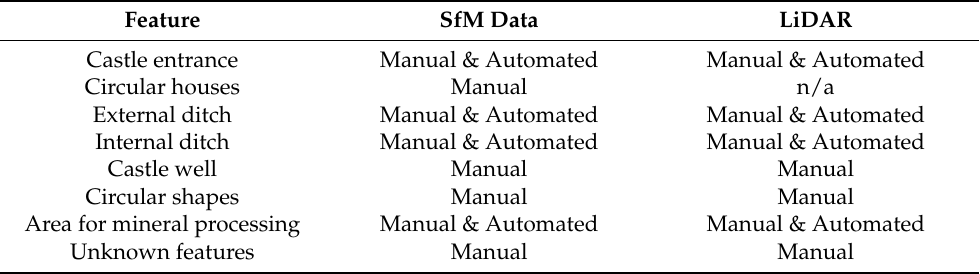
Manual Circular shapes Manual Manual Manual & Automated Manual & Automated Manual Manual